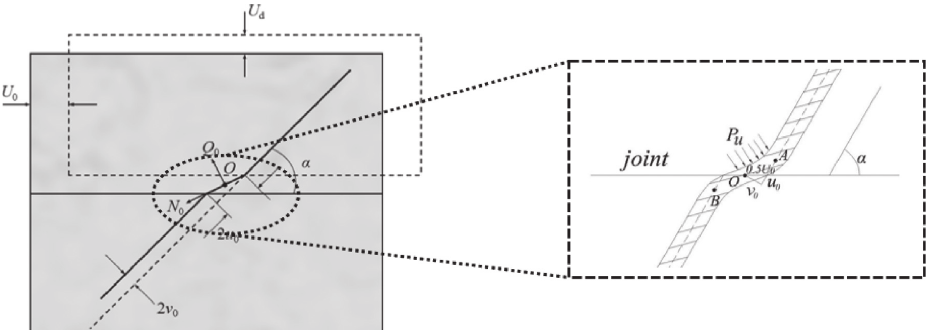
Figure 4: Schematic of joint and bolt deformation [17].